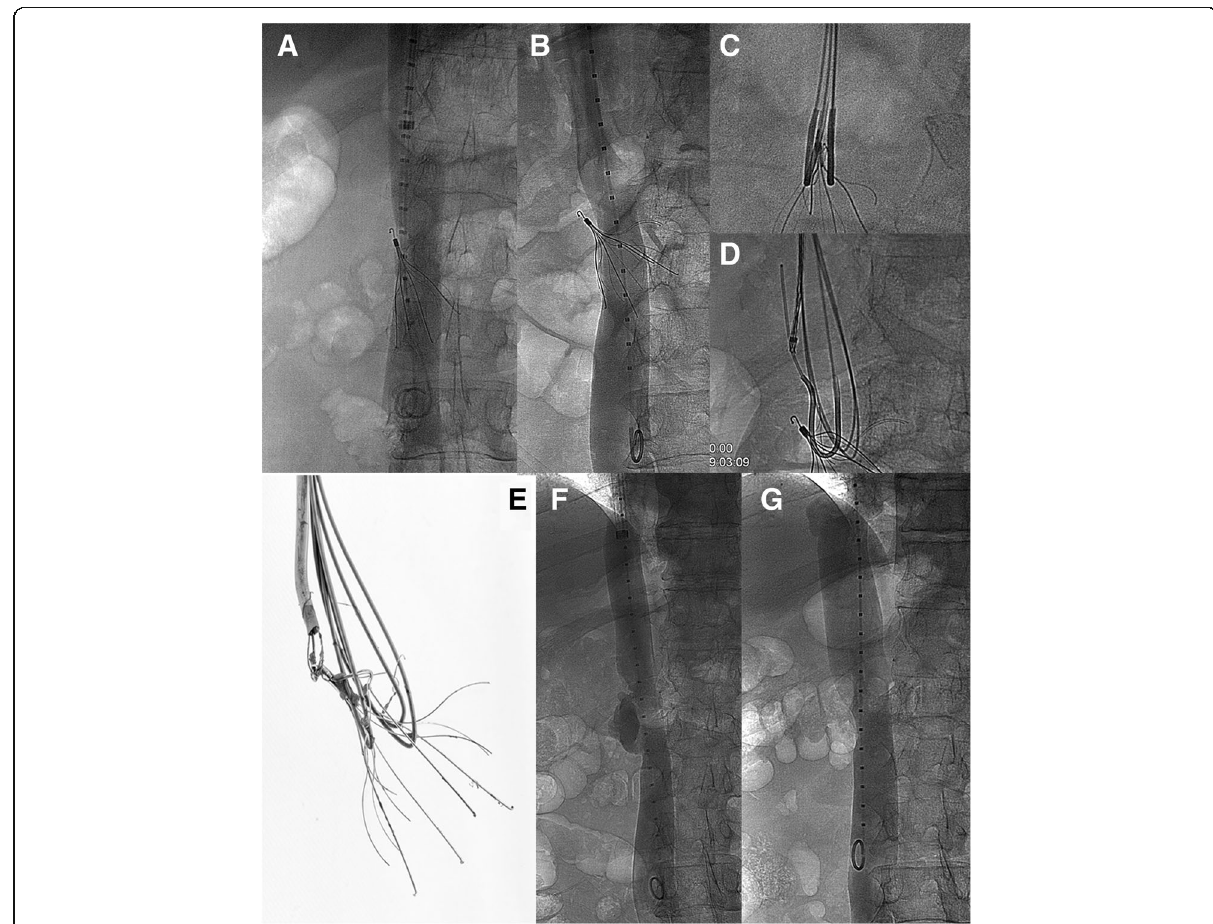
Fig. 1 a Venography of IVC before first removal attempt shows a tilted Celect filter with one leg protruding outside the IVC. b A repeat venography 8 years later shows a more tilted filter with a deeply embedded filter tip and two legs outside the IVC. c A lateral view confirms one loop on each side of the filter tip. d A third loop was created using a reversed shape catheter an exchange length guidewire and a snare. e Photography after explantation illustrates the three loops around different legs and arms of the filter. f Venography immediately after filter removal shows a contrast pocket at the location of the former filter tip location. g A control venography 6 weeks later reveals a smooth IVC